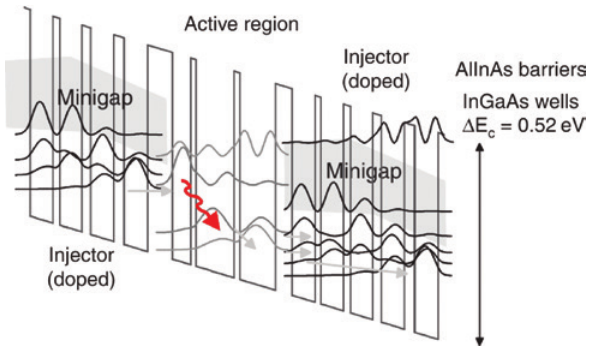
Figure 2: Schematic of the band structure of a